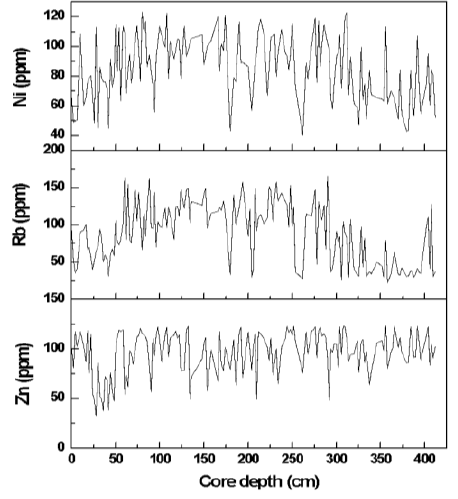
Figure 5: Down core variations of Zn, Rb and Ni Ni exhibits positive correlations with Fe (r = 0.64), V (r = 0.63), Rb (r = 0.62), K (r = 0.52), Mn (r = 0.44), Co (r = 0.42), Ca ( r = 0.40), Ti (r = 0.32), Zn (r = 0.25), Sr (r = 0.21), Cr (r = 0.10), Cu (r = 0.09), OC (r = 0.01), and negative correlations with CaCO 3 (r = -0.11), Sc ( r = -0.04)in the core.